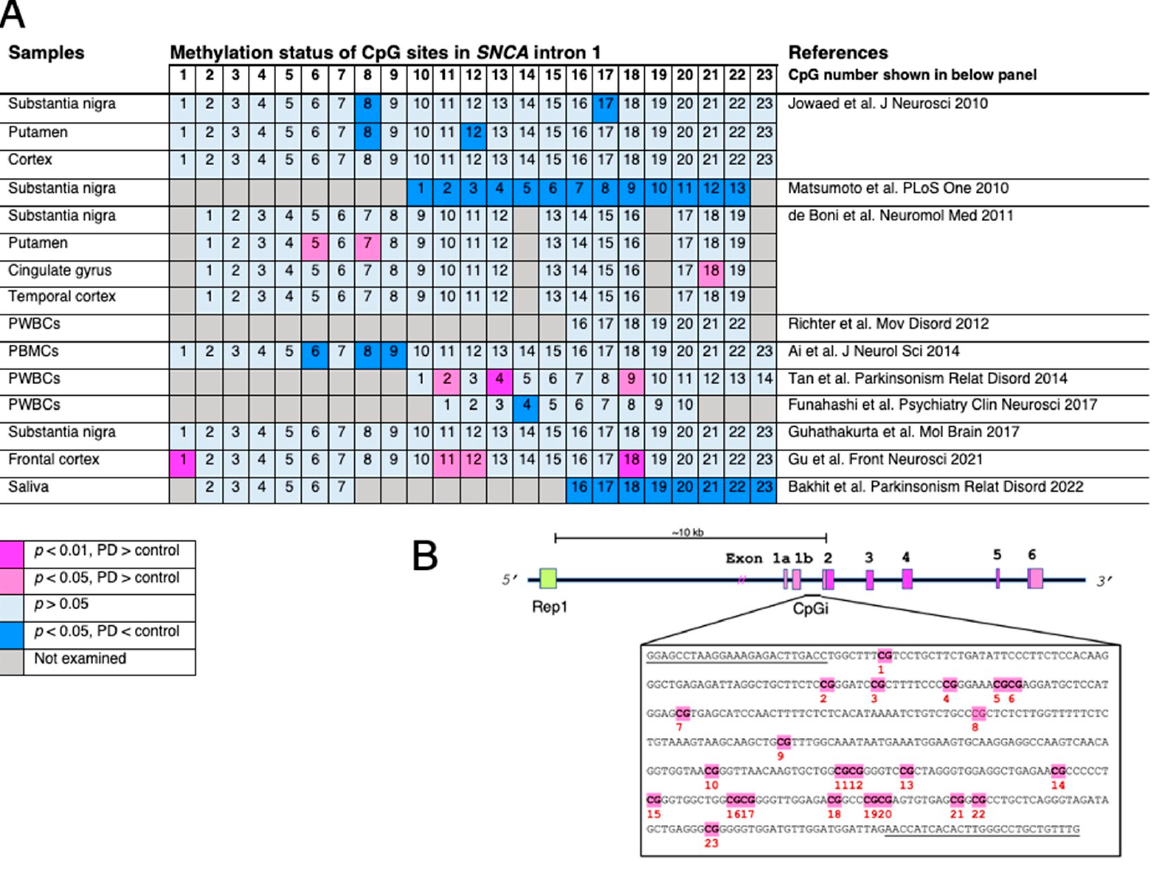
Figure 1. Changes in methylation status of CpG islands located in SNCA intron 1. ( A ) The indexed number of CpG sites is based on the report by Jowaed et al. [42–51]. The numbering of CpG sites is not identical in each study and is, therefore, corrected and displayed accordingly. Differences in methylation rates of CpG sites are compared between Parkinson’s disease (PD) or dementia with Lewy bodies (DLB) and healthy subjects or disease controls. The analyses are varied, but do not show consistent results. Nevertheless, CpG numbers 8 and 18 are likely more sensitive to the methylation modulating system or nuclear environment. ( B ) Schematic presentation of the human SNCA gene. Rep1, a dinucleotide repeat site, the length of which affects SNCA expression, located approximately 10 kb upstream from the start codon in exon 2. The CpG island located in intron 1 includes 23 CpG sites. Primer sequences for pyrosequencing by Jowaed et al. are underlined. The abbreviations used are as follows: PWBCs, peripheral white blood cells; PBMC, peripheral blood mononuclear